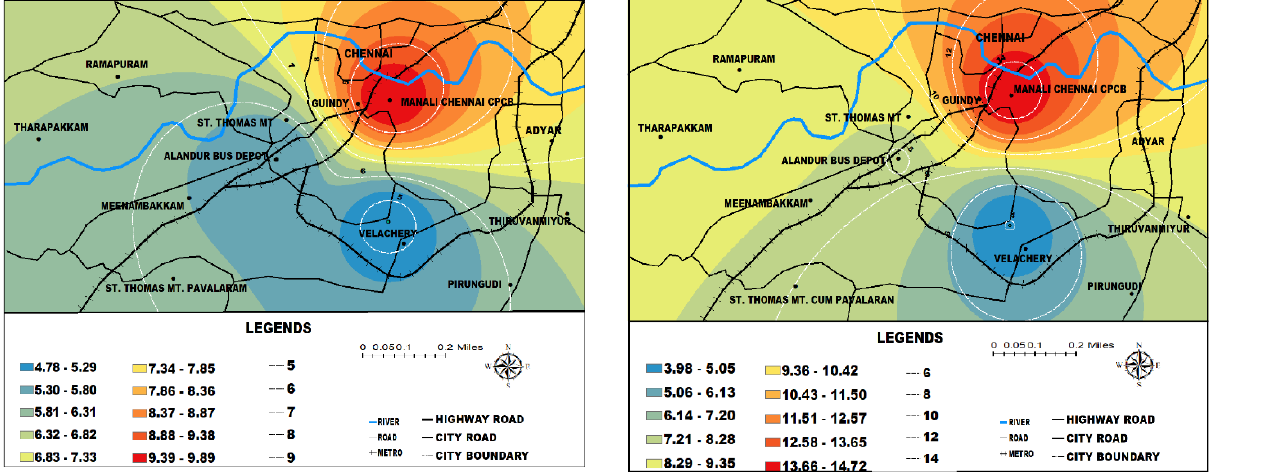
Figure 18. Air quality map of Chennai August monthly average based on SOx (µg/m 3